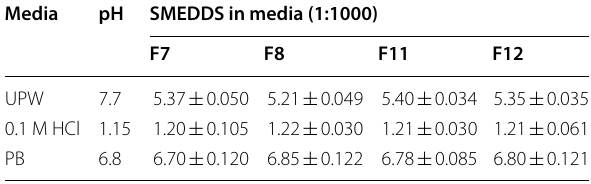
Each value represents the mean UPW ultra-pure water, PB phosphate buffer, HCl hydrochloric acid